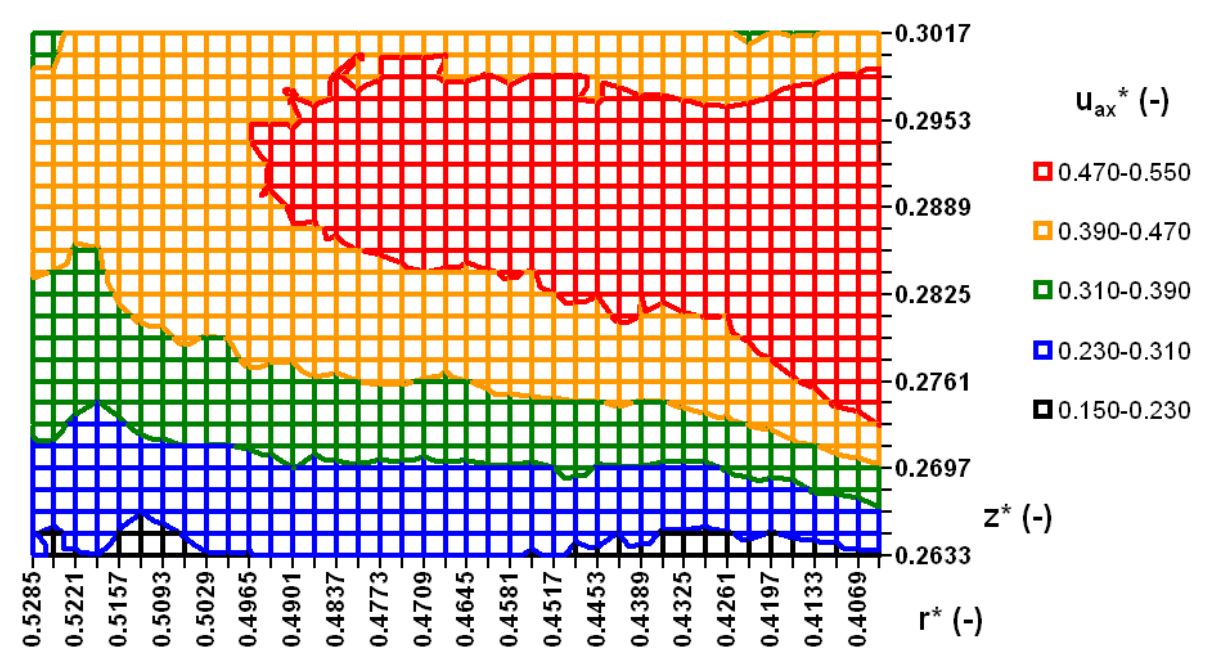
Fig. 5. Dimensionless axial fluctuation velocity distribution u ax* = )/( NDu